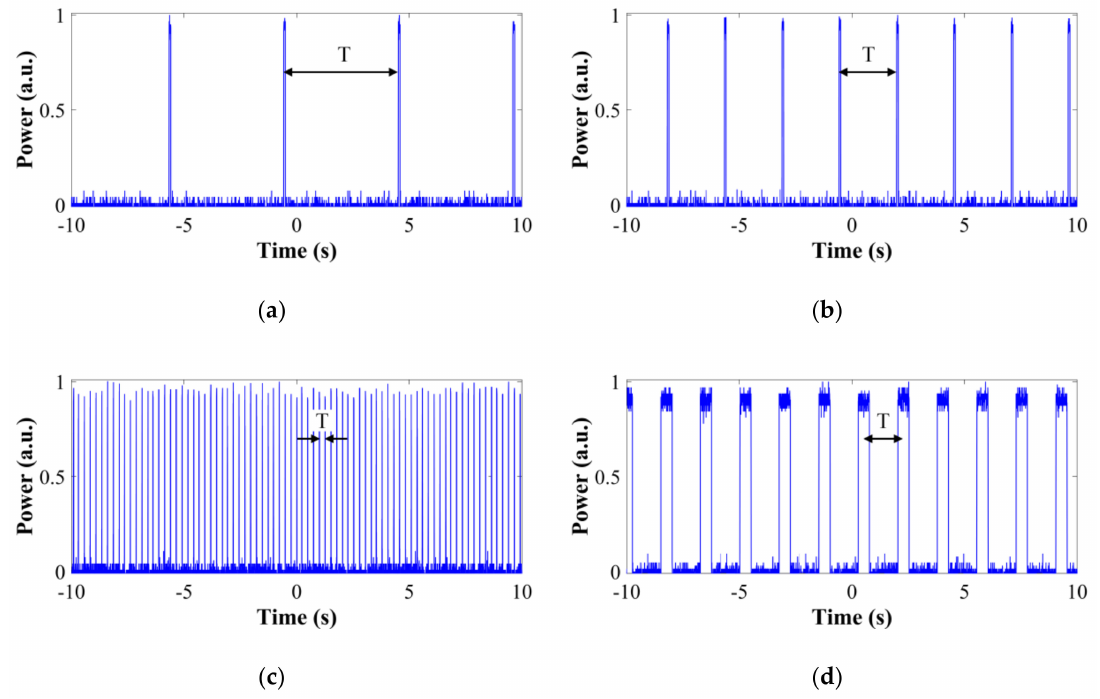
Figure 3. Train of pulses of 50 ms: ( a ) T = 5 s and ( b ) T = 2.5 s. ( c ) Train of pulses of 10 ms, with T = 0.26 s. ( d ) Train of pulses of 0.5 s (T = 1.75